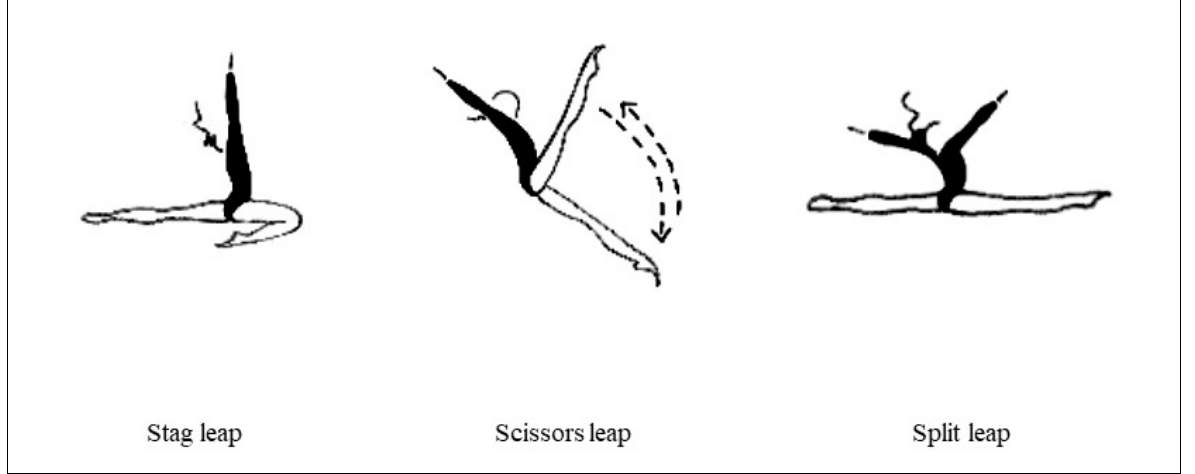
Figure 3. RG-specific jump tests performed